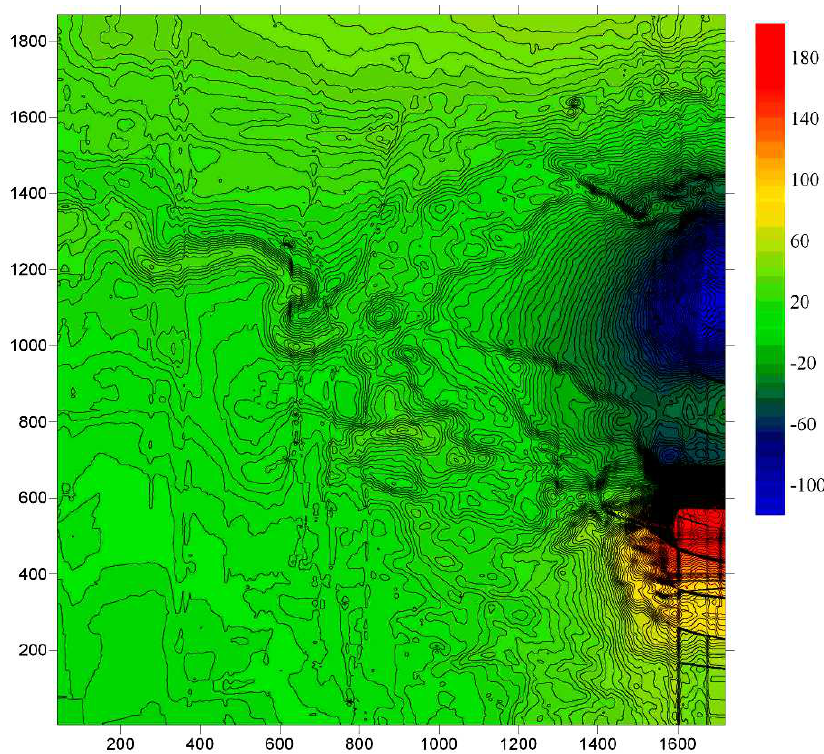
Figure 6. Contour map of all survey area. Color scale is in nT and grid is in meters .